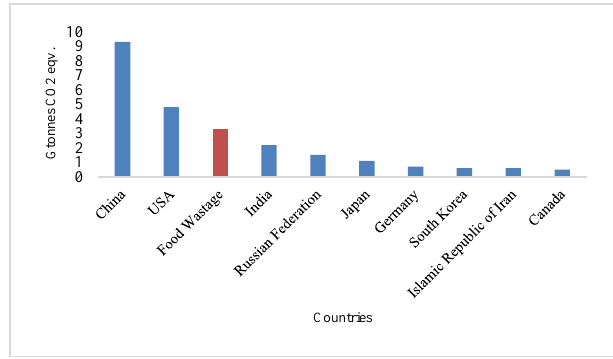
Figure 4: Greenhouse gases emission by countries (FAO, 2011a)